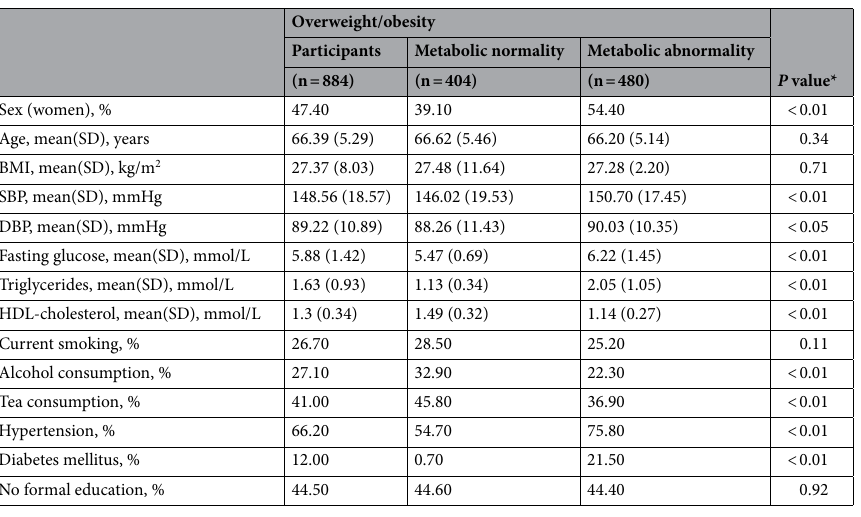
Table 1. Demographic, somatometric, and laboratory parameters in MHO and MUO individuals. SD standard deviation, BMI body mass index, SBP systolic blood pressure, DBP diastolic blood pressure, HDL high-density lipoprotein. * P values represent difference in characteristics by metabolic syndrome status based on analysis of